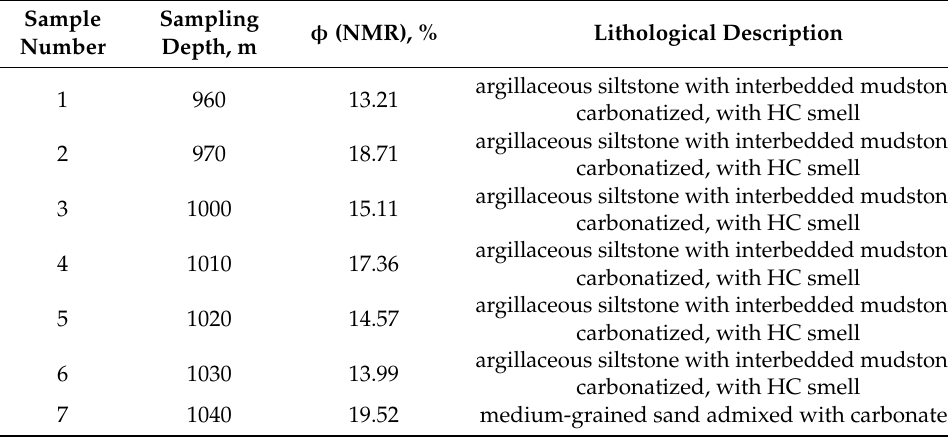
Table 3. Lithological description of the drill